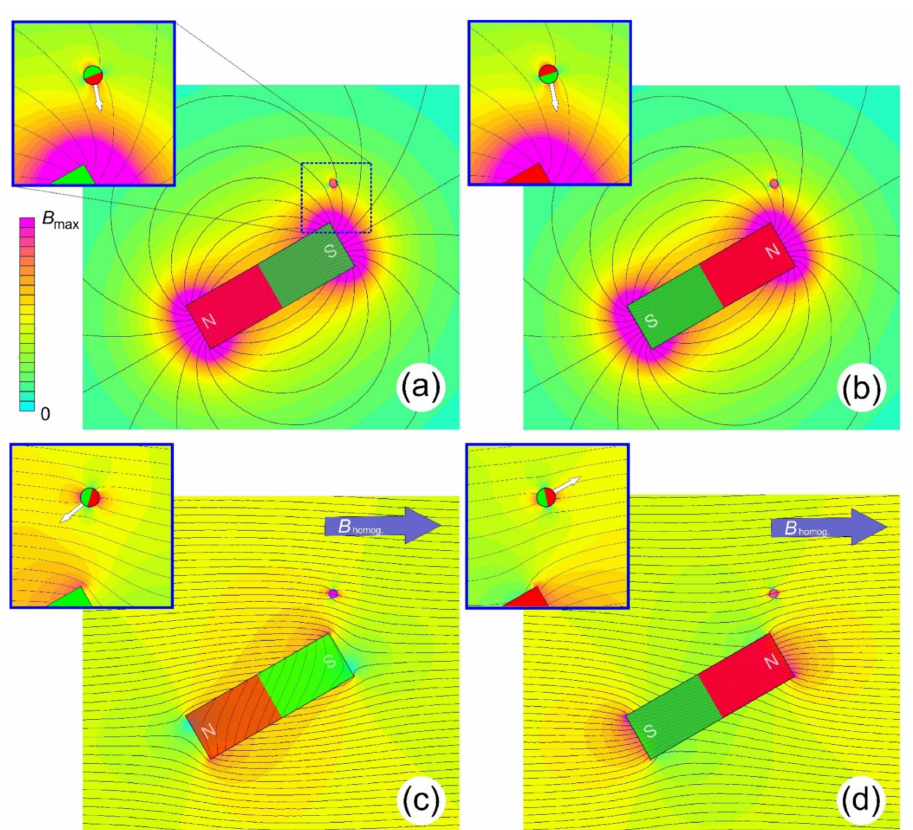
Figure 1. Illustration of the suggested guiding principle. A small magnetizable sphere serves as the object to be guided by a large deflecting bar magnet. The colors indicate the magnitude of the local magnetic flux density (see color bars on the left, B max in ( a , b ) is roughly a quarter of that in ( c , d )). The black lines are field lines. A zoom of the region around the object is shown on the inserts. The top rows ( a , b ) just show the field generated by the deflection magnet, while in ( c , d ) a strong and homogeneous field is superimposed to the scenario above. The difference between the columns is the orientation (south- and north-pole) of the deflection magnet. ( a , b ) Changing the magnet’s orientation has no effect on the movement of the object (white arrow), because the object is magnetized in opposite directions as well and just moves to the highest flux density. The additional homogeneous field in ( c , d ) essentially keeps the magnetization direction of the object along its horizontal